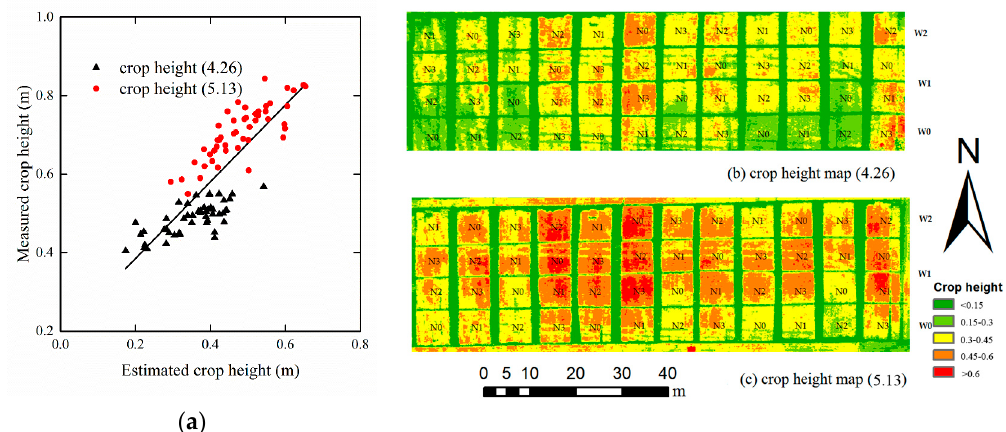
Figure 7. Crop height: ( a ) estimated and measured crop height; ( b ) crop height on 26 April 2015; ( c ) crop height on 13 May 2015.